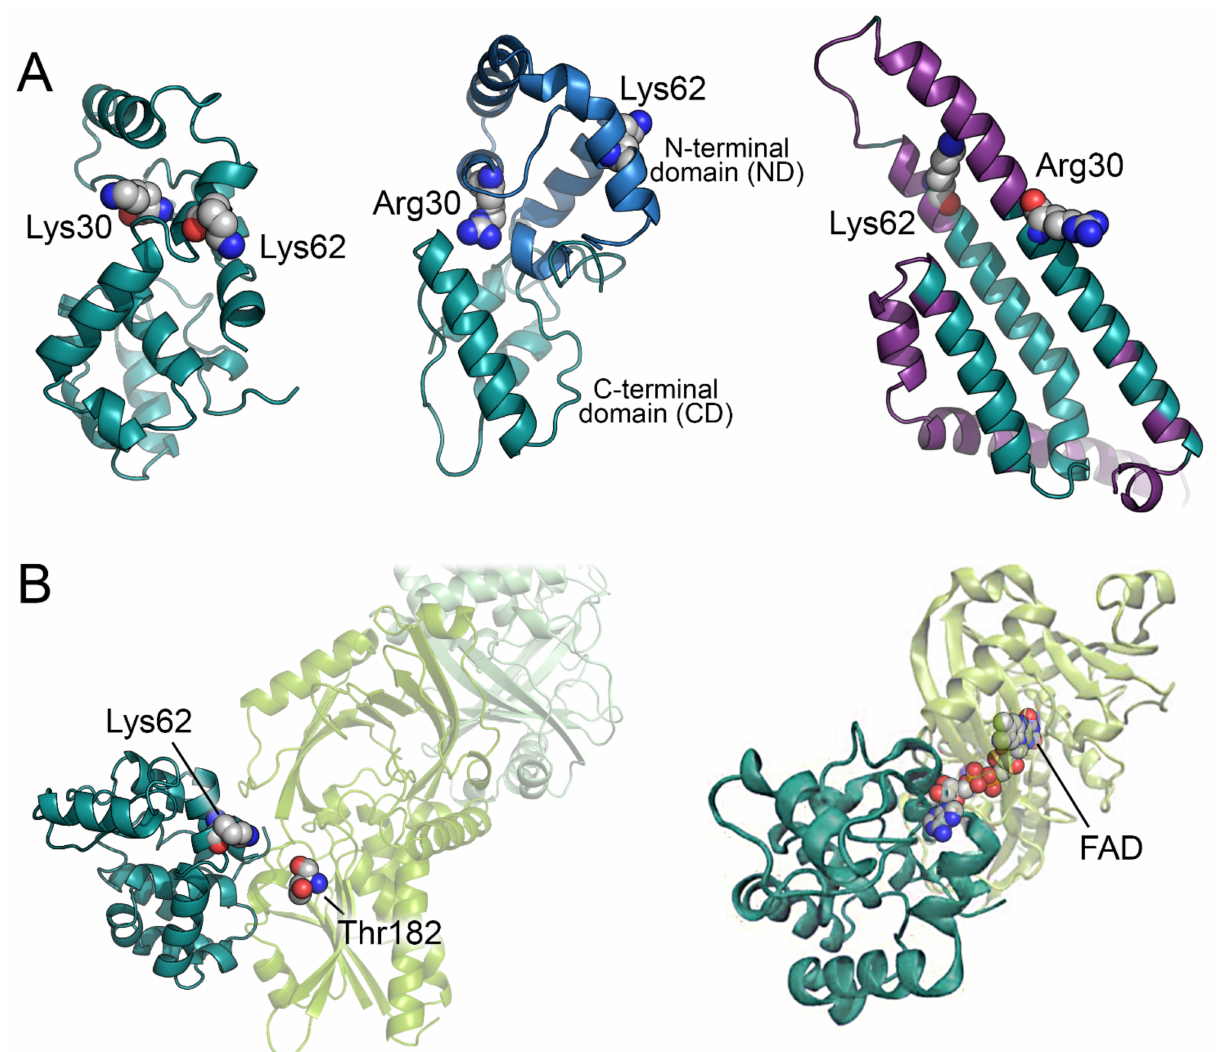
Figure 2. Predicted models of the pLG72 3D structure and of the pLG72-hDAAO complex. ( A ) 3D models of pLG72 as predicted by [30] ( left ), [31] ( center ), and AlphaFold ( right ). In the latter structure, regions with an pLDDT < 50 are depicted in purple. ( B ) Predicted interaction between pLG72 and hDAAO as reported in [30] ( left ) and [32] ( right ). pLG72 and hDAAO are represented as cartoon (teal and pale green, respectively). Significant residues of pLG72 and Thr182 of hDAAO are shown as grey